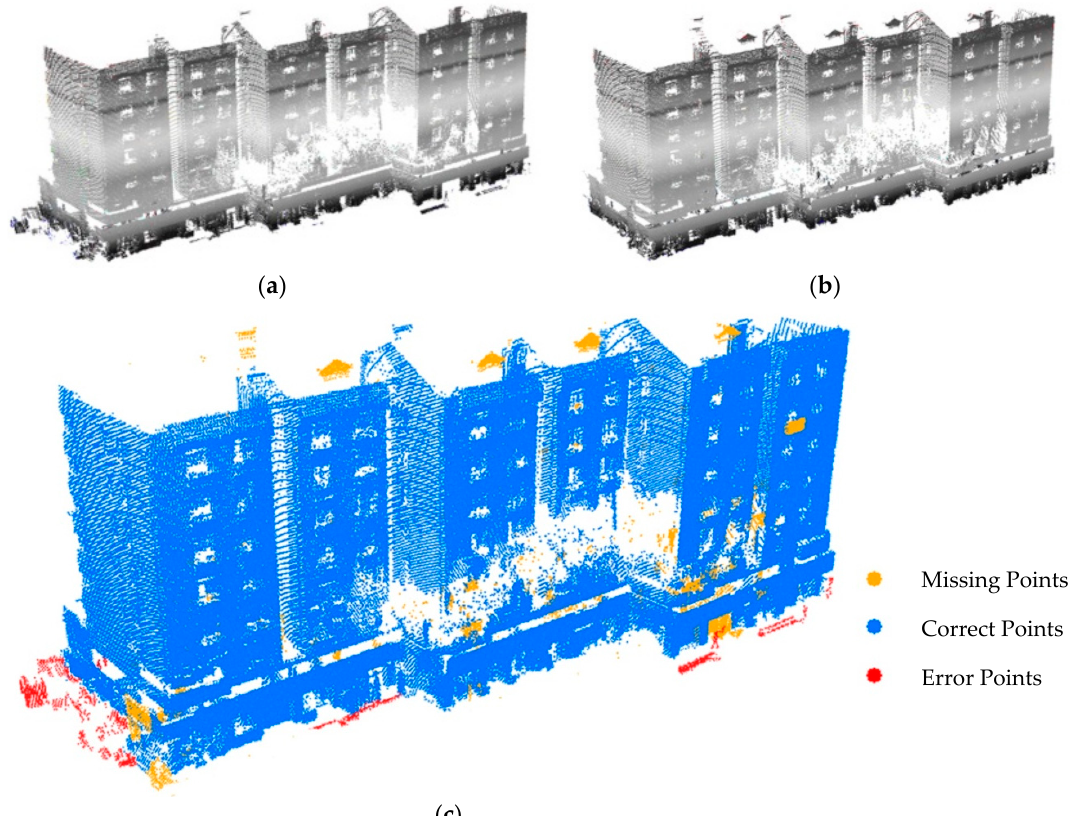
Figure 11. Point-based evaluation for individual building. ( a ) Automatic extraction results of a building; ( b ) Manual extraction results of the same building; ( c ) Overlay result with the correct, error, and missing points denoted in blue, red, and yellow, respectively.